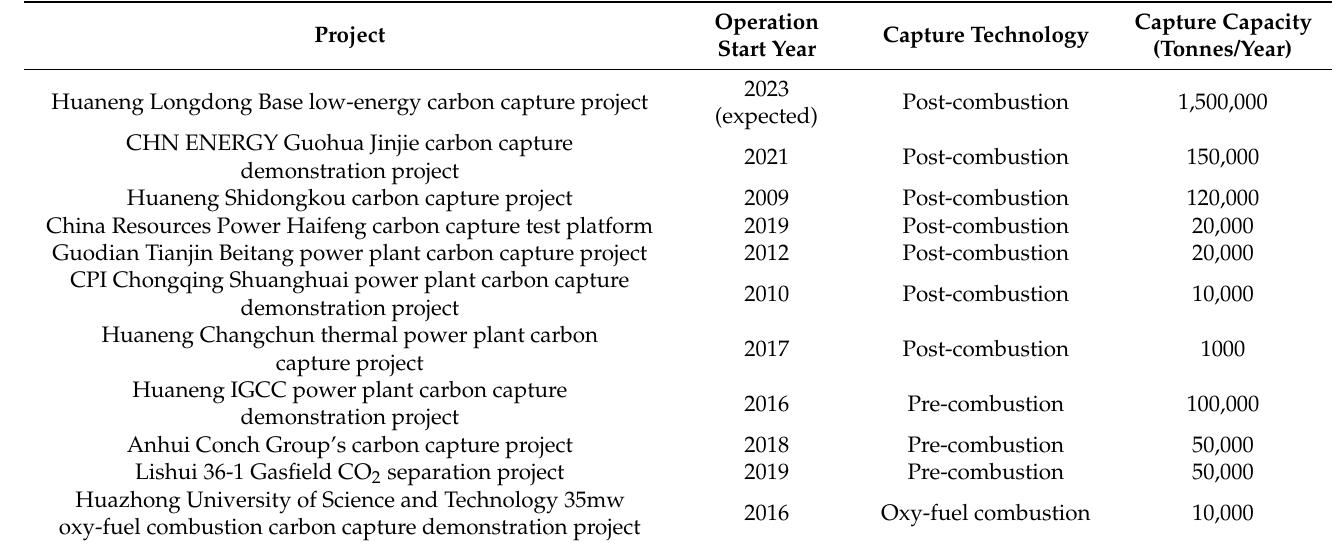
Table 4. CO 2 capture projects in China